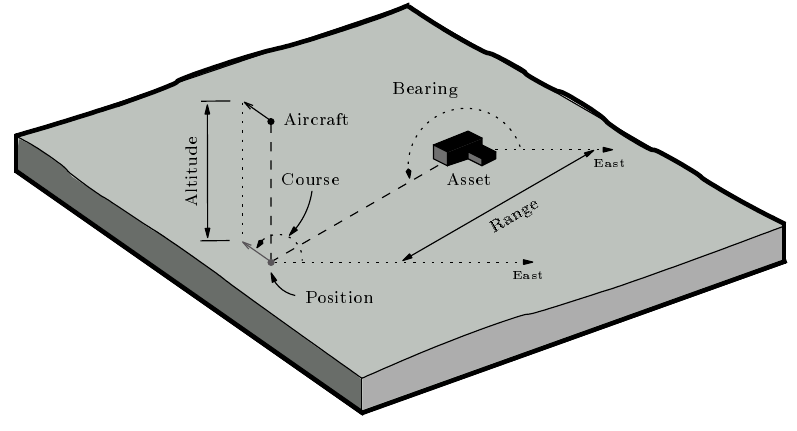
Figure 3: Various aircraft